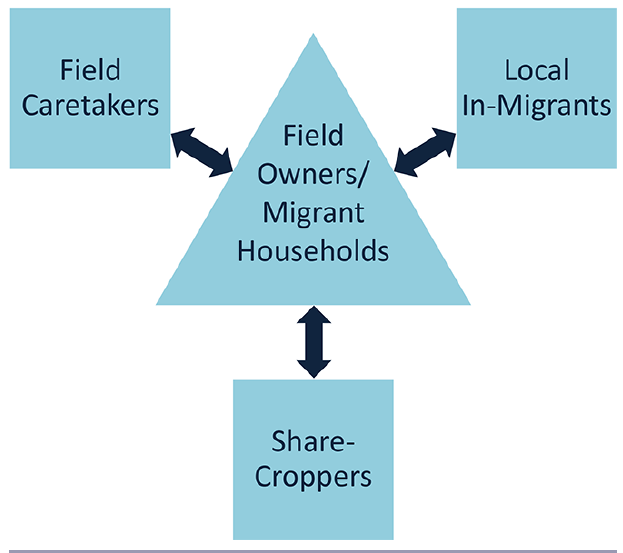
Fig. 5 . Interconnections of migration-related livelihood groups in agrobiodiversity resilience and